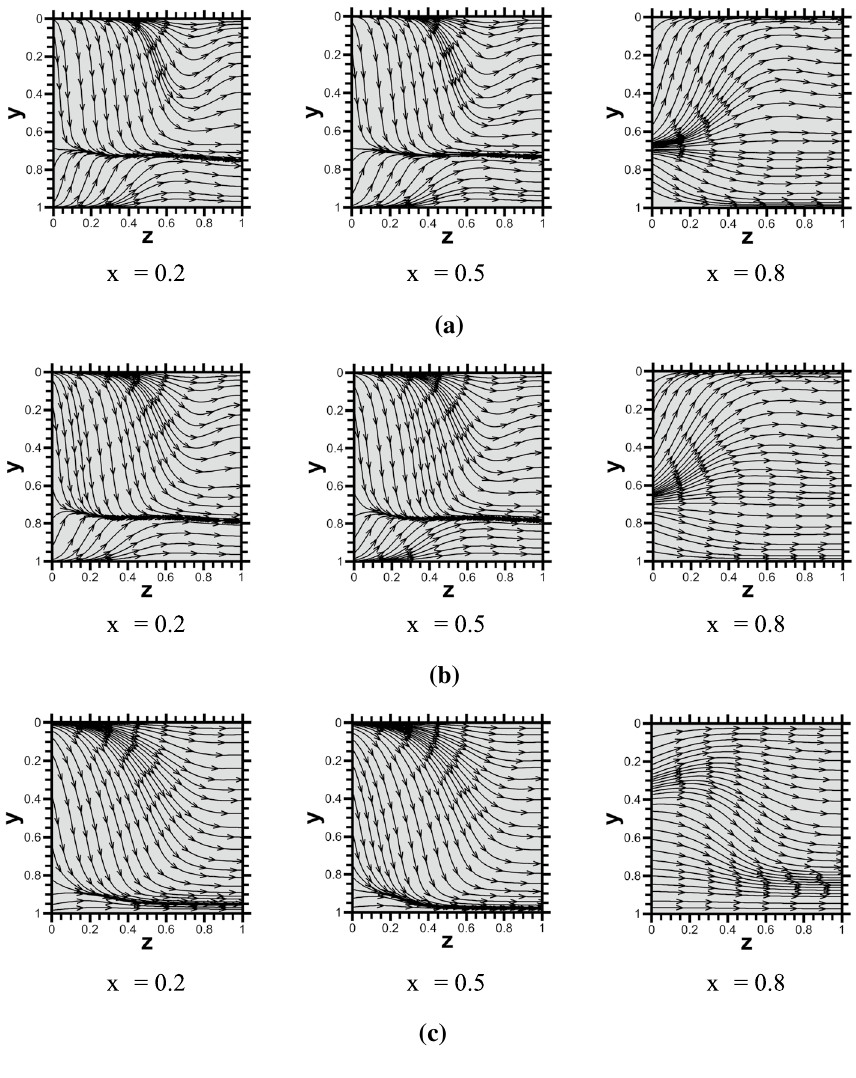
Fig. 16 A sample of the stream lines in the transverse section for passing plates through the 𝜐 length ( = 0.05) a t = 0.05, b t = 0.1, c t =